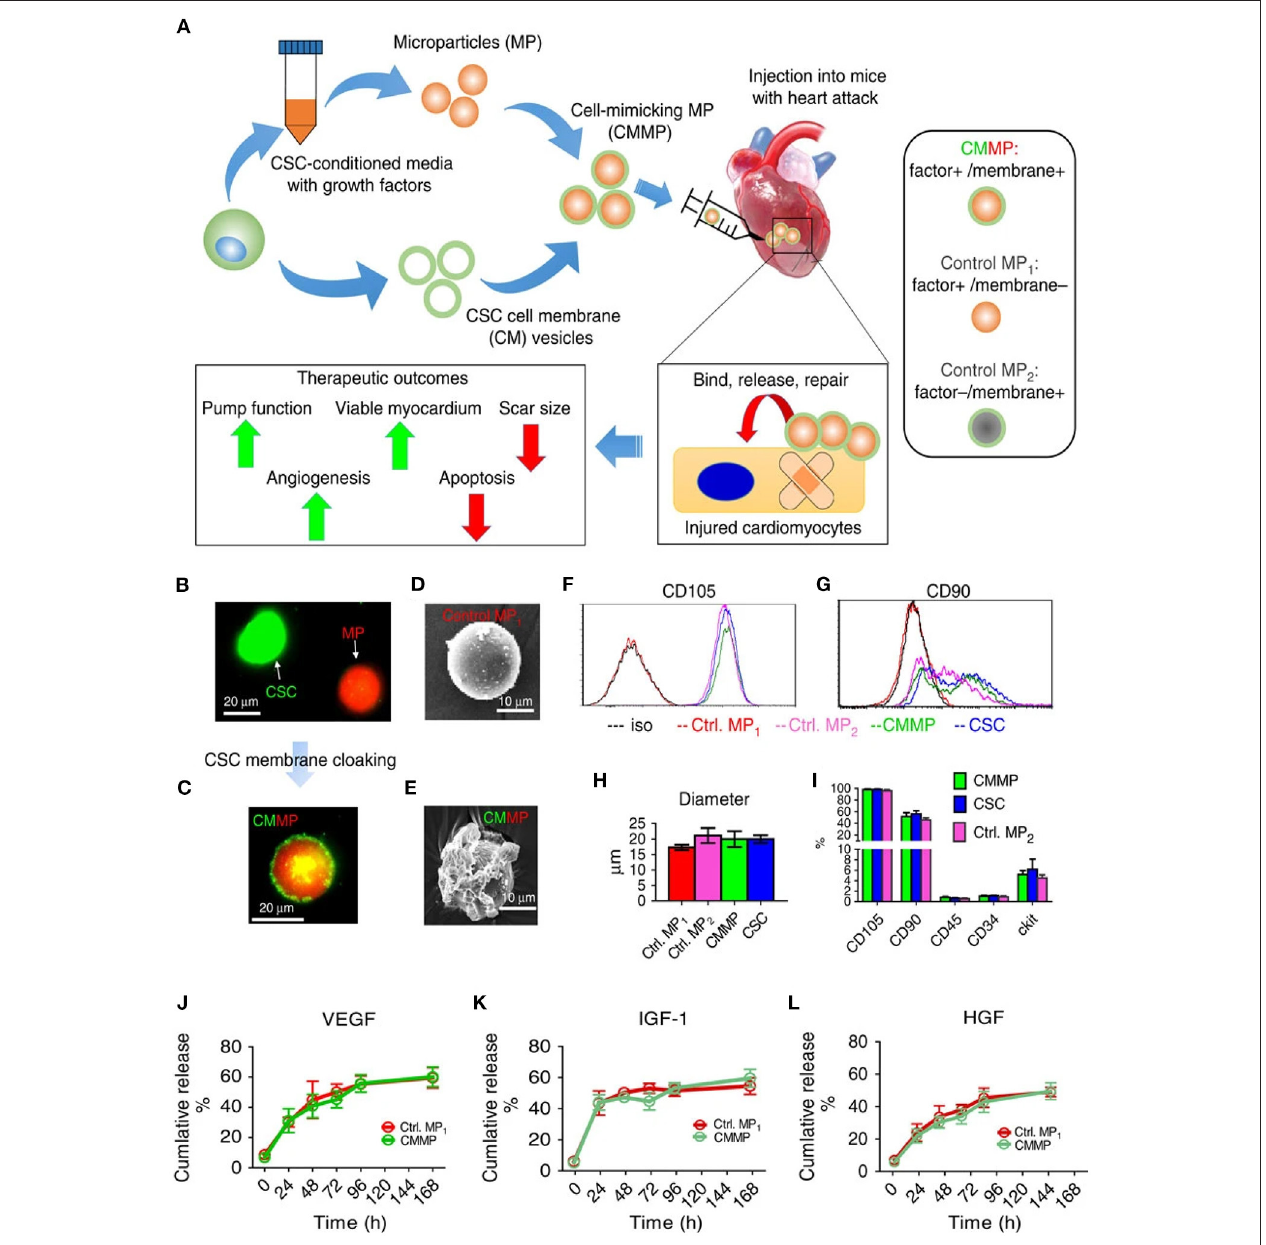
FIGURE 3 | (A) Schematic representing cardiac stem cell (CSC) mimicking microspheres fabricated by coassembly of CSC-derived membranes on polymeric microspheres. (B,C) Fluorescence imaging of CSC (green) and microsphere (red) tagged with fluorescent dyes (D,E) SEM of blank microsphere and CSC coated microsphere. (F,G) Evaluation of CSC markers on fabricated hybrid microspheres. (H) Size analysis of hybrid microspheres and respective controls. (I) CSC antigen analysis of hybrid microspheres. (J–L) VEGF, IGF-1, and HGF growth factors release profiles from the hybrid microspheres, respectively